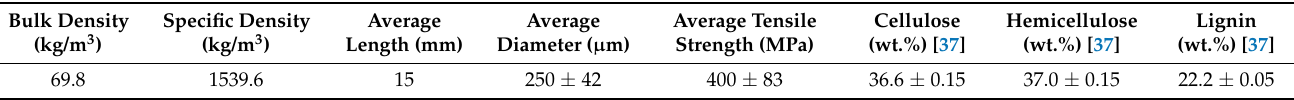
Table 2. Sugars concentration in the leachates from coir